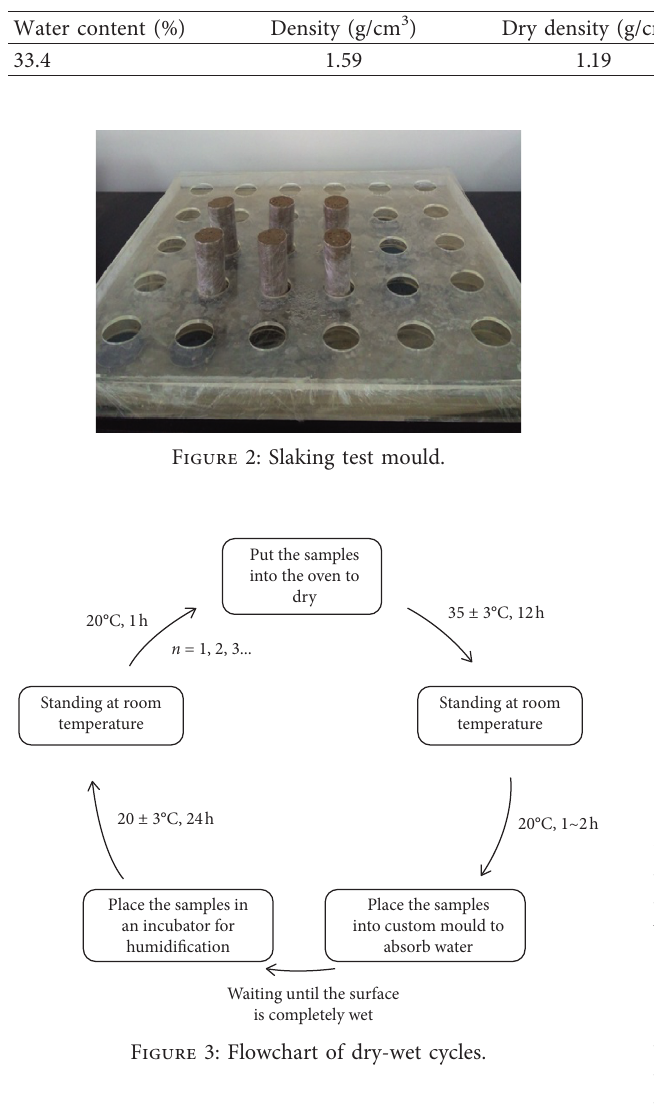
Table 4: Basic physical properties of sludge solidified soil.